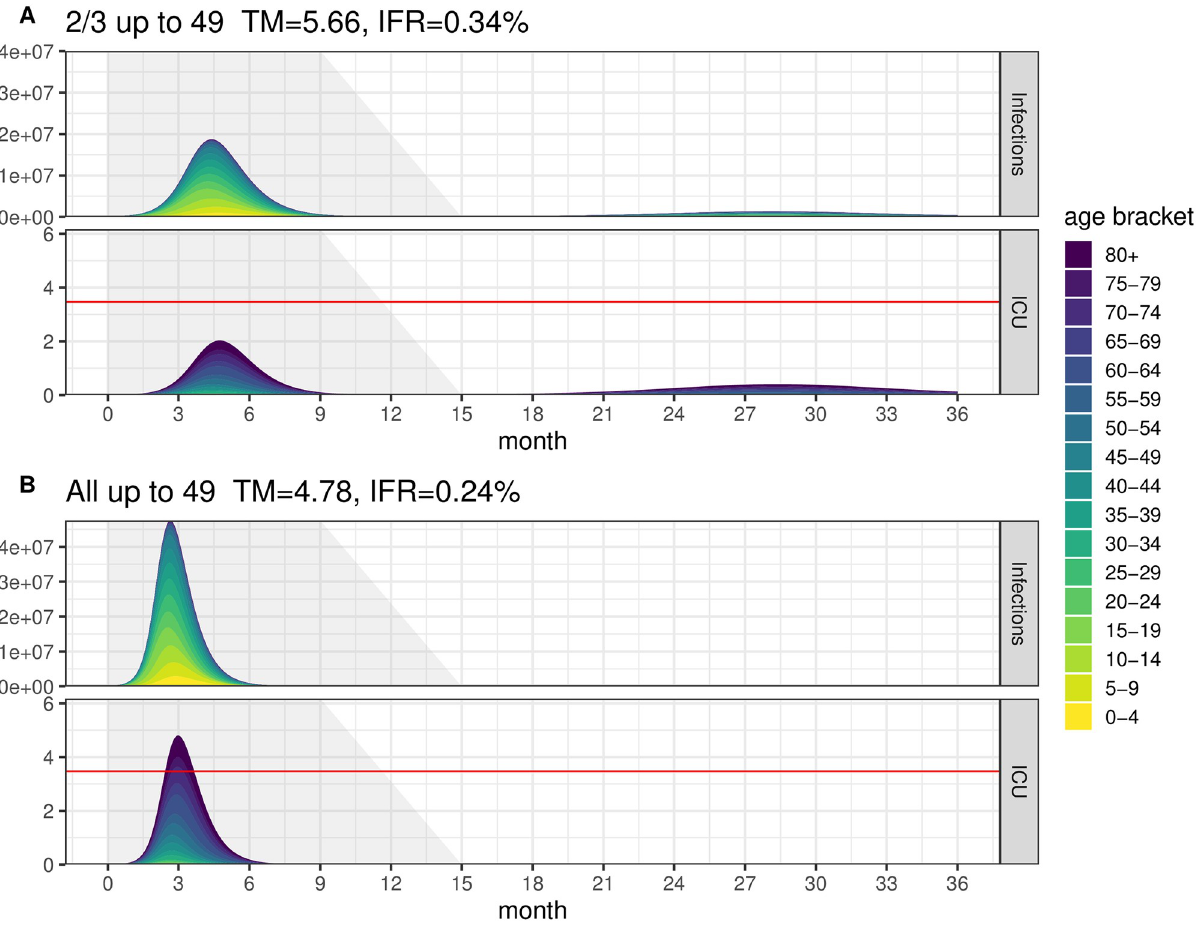
Fig 5. A : 2/3 under 49 released at normal levels. B : All under 49 released at normal levels.